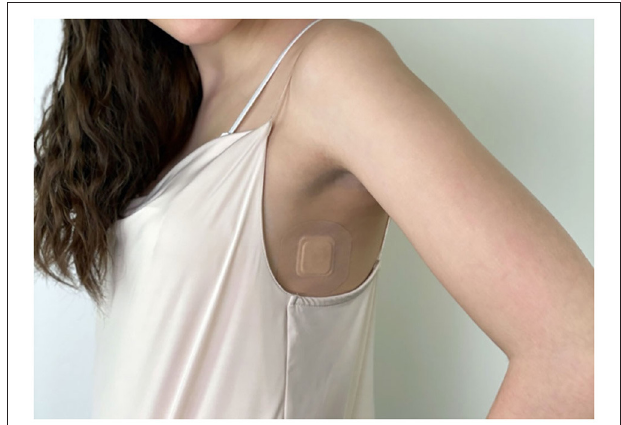
FIGURE 1 | Applied patch in typical location.